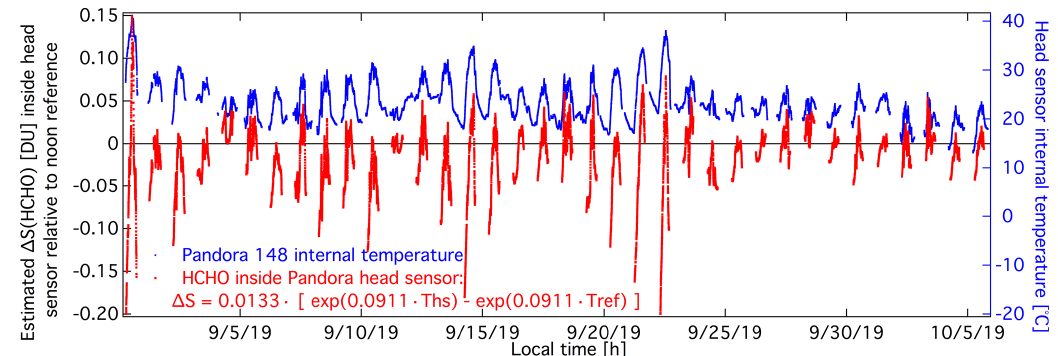
Figure 12. Estimated (cid:49)S HCHO contributing to the multi-axis measurements while local noon reference is used. This is relevant only to DOAS instrument intercomparison campaigns such as CINDI-2 since standard data inversion requires individual scan reference. Exponential production amplitude applied is 0.0133DU; however, the actual amplitude observed in the lab was between 0.0041 and 0.049. (cid:49)S HCHO is calculated based on Pandora 148 head sensor temperature during TROLIX’19 campaign west of Rotterdam, the Netherlands, during 31 August to 5 October 2019.